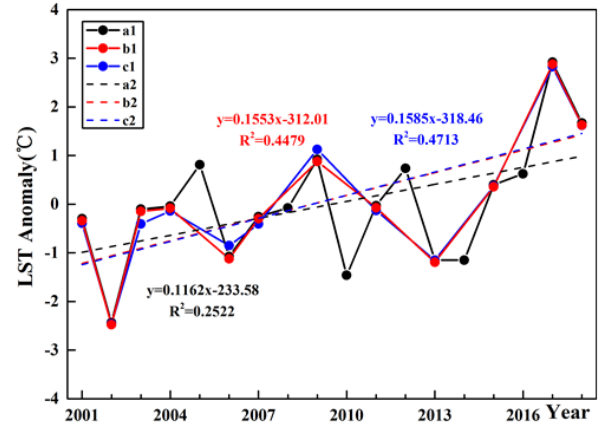
Figure 9. Average number of clear days per winter month (December, January, and February) from 2001 to 2018. The black dots indicate the 26 pixels that were selected to calculate the LST (land surface temperature) trends for all three winter months.